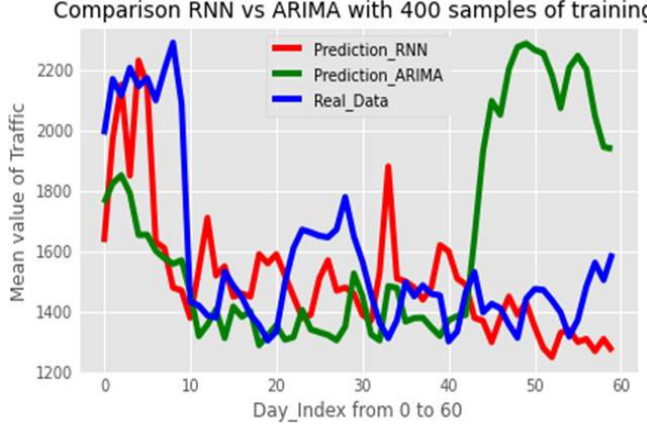
Figure 9. RNN predictor and ARIMA predictor for 400 training